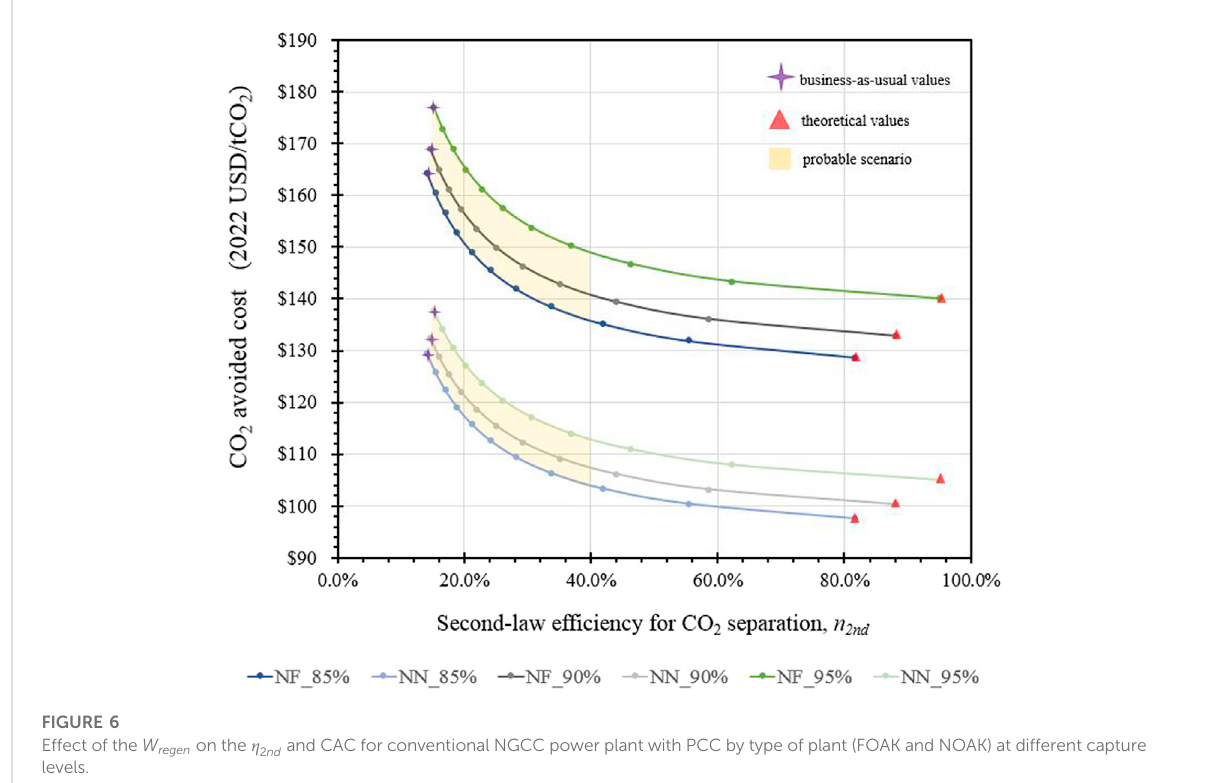
FIGURE 6 Effect of the W regen on the η 2 nd and CAC for conventional NGCC power plant with PCC by type of plant (FOAK and NOAK) at different capture levels.